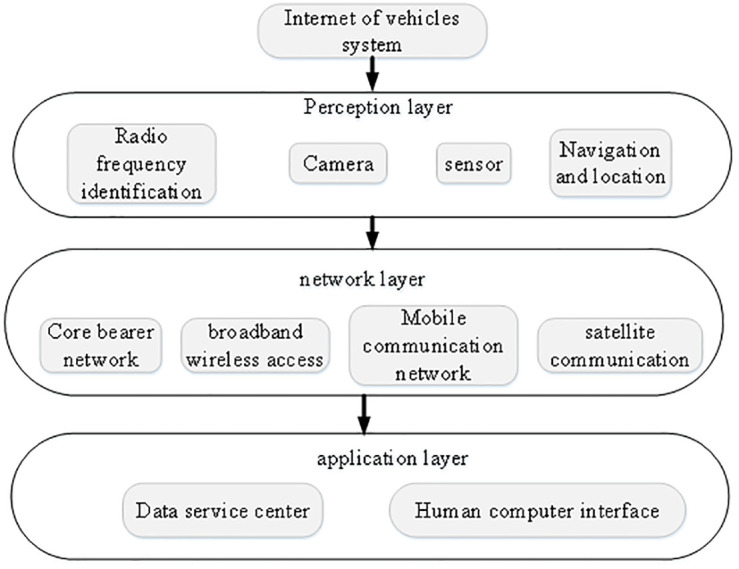
System and architecture of IoV.